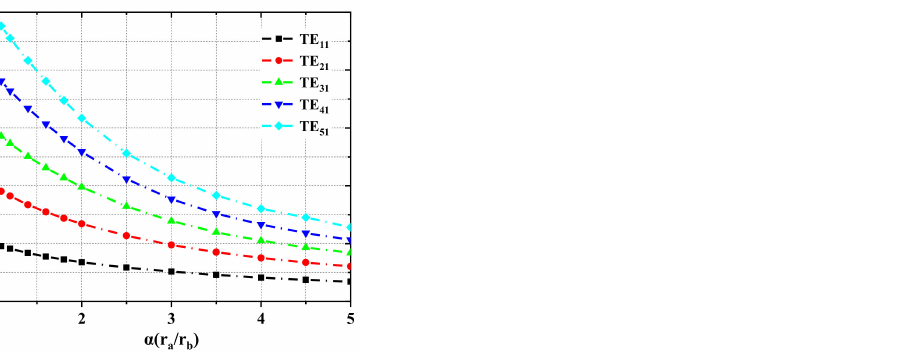
Figure 2. The relationship between the Eigenvalue root χ m , n and the inner coaxial cavity and outer coaxial cavity radii ratio a .